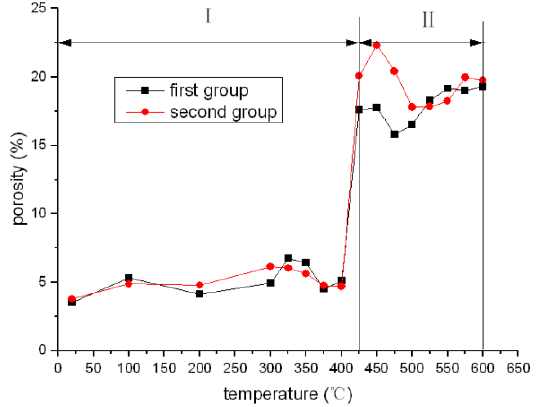
Figure 8. The sample porosity versus temperature of the two group samples: I: low porosity stage before pyrolysis; II: high porosity stage after pyrolysis.